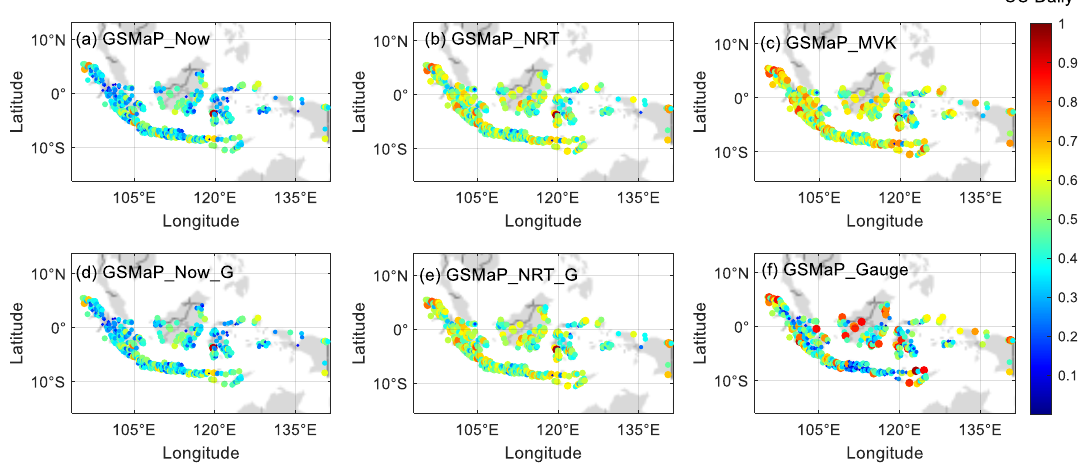
Figure 12. Spatial distribution of CC values for GSMaP_Now (a), GSMaP_NRT (b), GSMaP_MVK (c), GSMaP_Now_G (d), GSMaP_NRT_G (e), and GSMaP_Gauge daily data against gauge data over IMC. Figure 12 shows the spatial distribution of the CC values of the daily GSMaP against gauge data for the entire IMC region. The spatial distribution of CC values confirms the low CC values in the Sulawesi region, especially at stations located around mountainous areas (Figure 1). The low CC values in the mountains of Sulawesi are observed in GSMaP real-time data (Figure 12a,d) and near-real-time GSMaP (Figure 12b,e). Good CC values were observed in the northwestern part of Kalimantan. This is probably because the loca- tion is a flat surface area (Figure 1). In addition, the area was also not at the peak of the rainy season in this study period [62], so the contribution of extreme rain to the validation process was not dominant. The spatial distribution of CC values also shows low GSMaP_Gauge values concentrated in areas with complex topography, such as Sumatra, Sulawesi, and Java. Thus, there may be an overcorrection process in the GSMaP_Gauge data for the mountain area. Table 9. Statistical parameter correlation value to altitude. Parameter